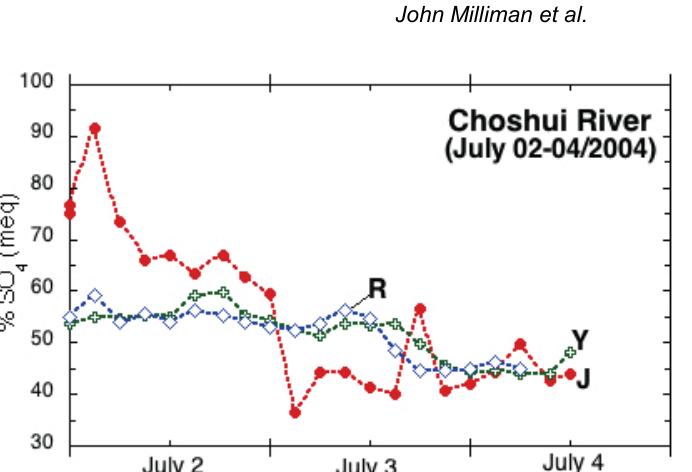
Fig. 12 Temporal and spatial variations of S0 4 relative to total anions (meq) at Choshui River stations R, Y and J, 2–4 July 2004.